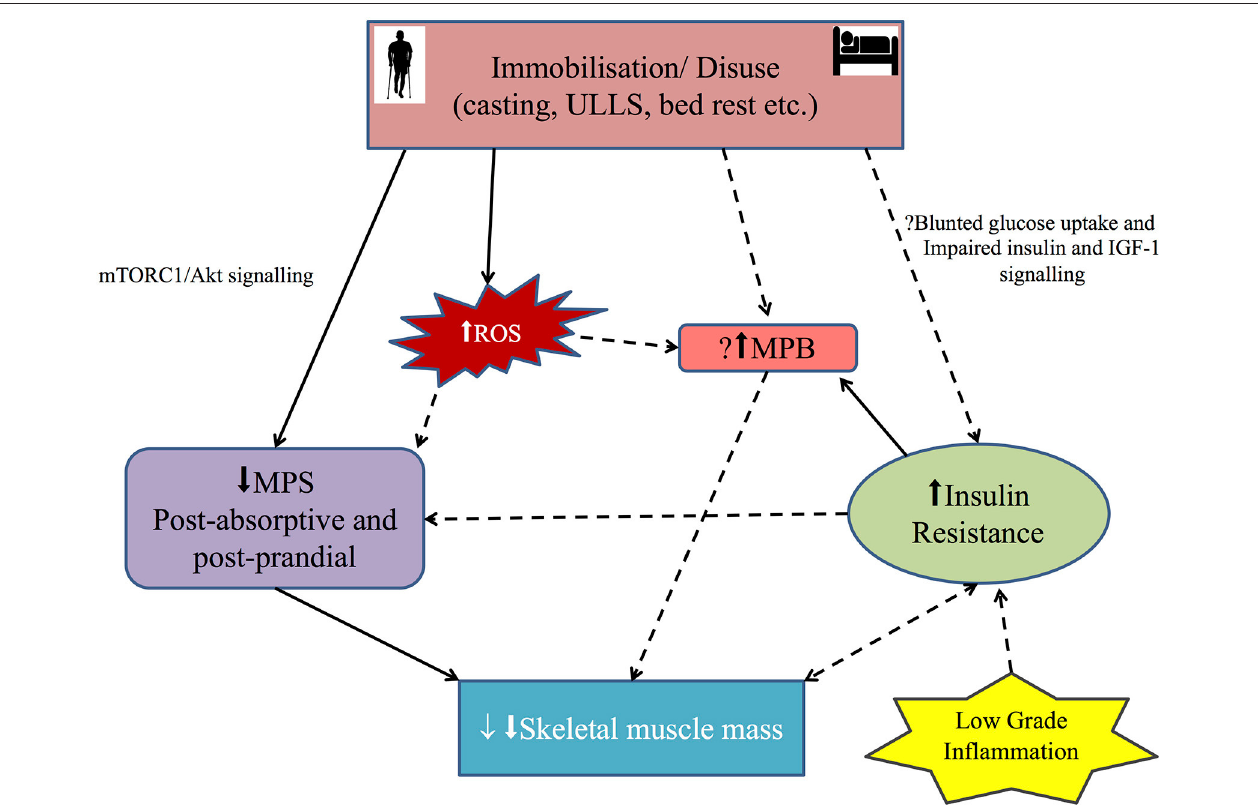
FIGURE 1 | Diagrammatic representation of the main mechanisms involved in disuse skeletal muscle atrophy in humans: Immobilization/disuse reduces both postabsorptive and post prandial muscle protein synthesis (MPS) via the mammalian target of rapamycin (mTORC1) and Akt signaling. The role of MPS, muscle protein breakdown (MPB) and insulin resistance (IR) in simple disuse atrophy remain poorly defined in humans. So the role of insulin resistance and MPB in the setting of disuse atrophy needs further evaluation. Inflammation probably leads to IR. Recently, reactive oxygen species (ROS) has been implicated in development of muscle atrophy in disuse setting, but the mechanism in human remains putative. Solid arrow shows positive association and broken arrow shows putative association. See text for more details.